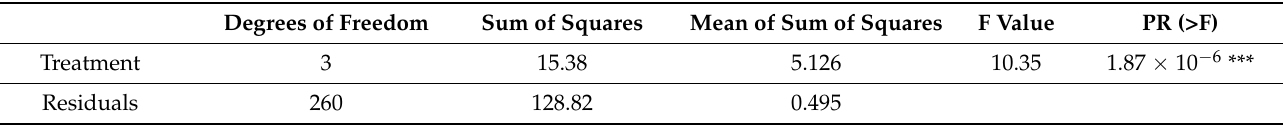
Table A12. Summary of Anova analysis for culicines.